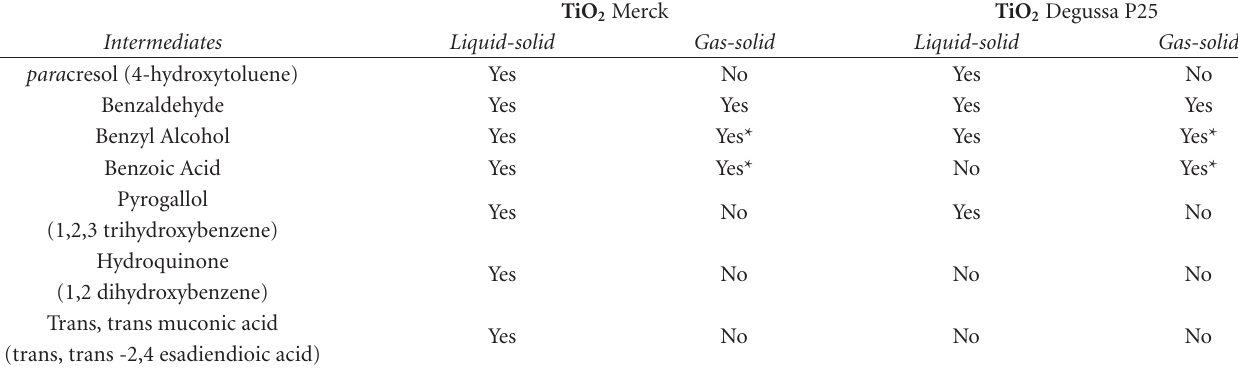
Table 1: Photocatalytic degradation of toluene. Intermediates detected in liquid-solid regime and in gas-solid regime.